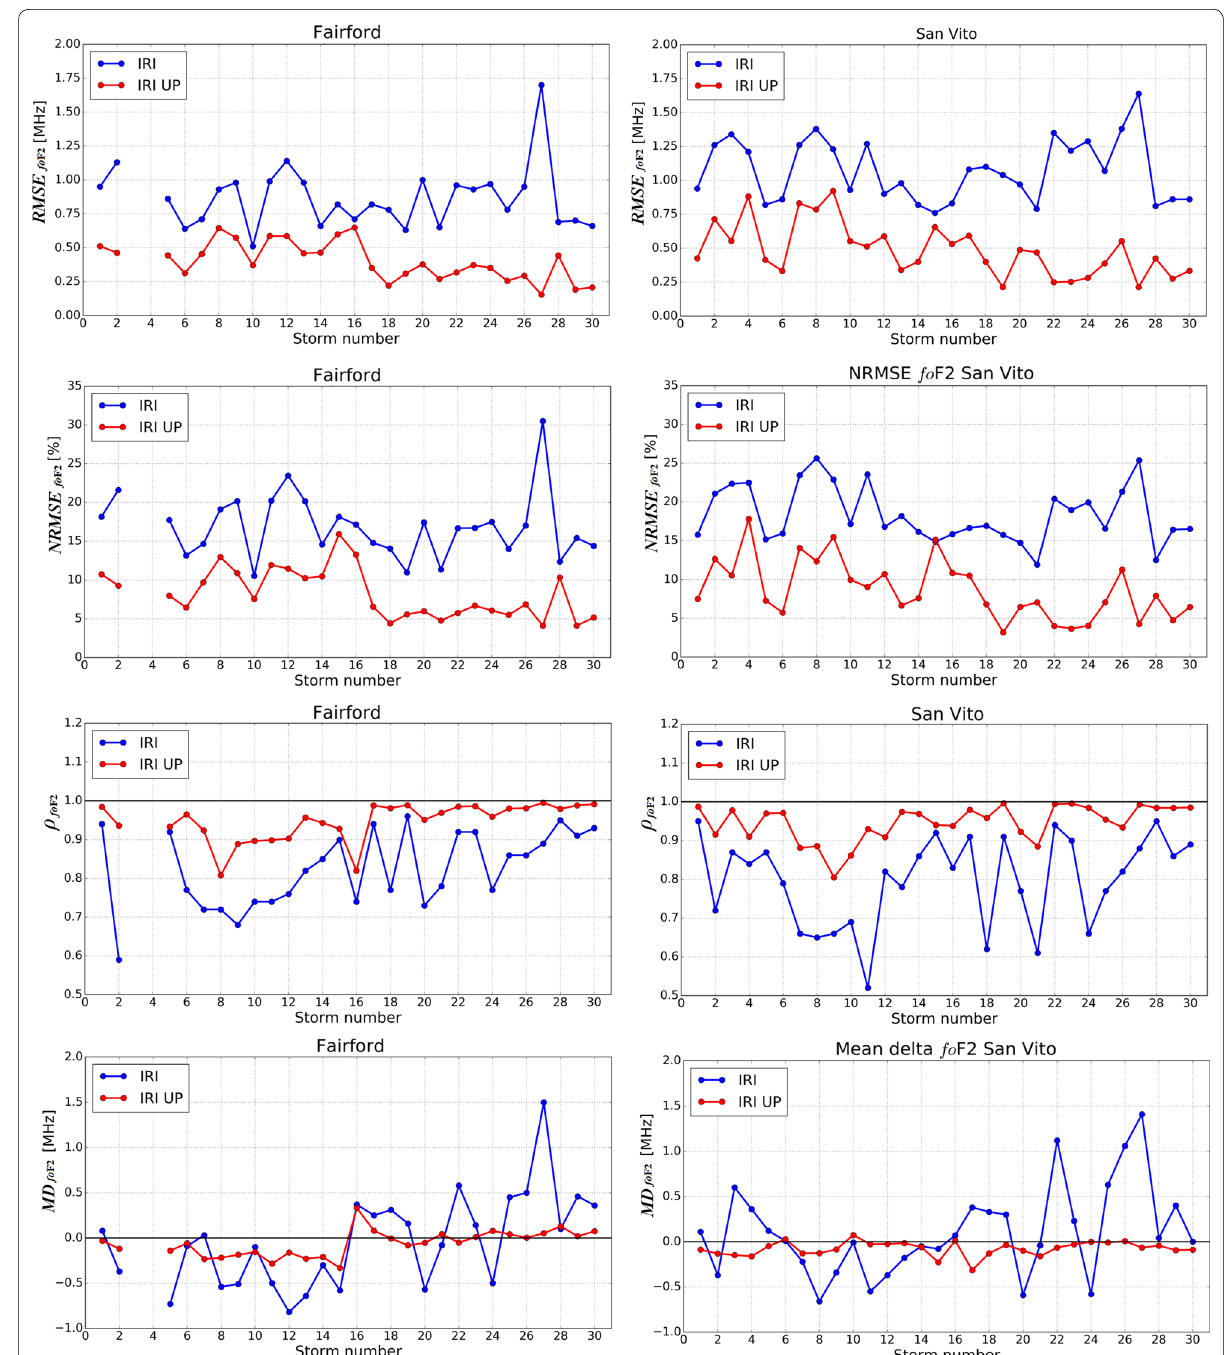
Fig. 10 Statistical parameters calculated at testing stations for fo F2, for each storm time period. Trend of statistical parameters defined by Eqs. (27)– (30) related to fo F2 for Fairford (left) and San Vito (right). The gap between storms number 2 and 5 at Fairford is due to the lack of ionosonde